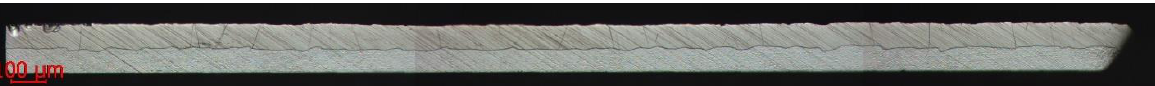
Figure 1. Micro photo of the etched angle lap of a y+128°-cut LN crystal with bidomain structure.